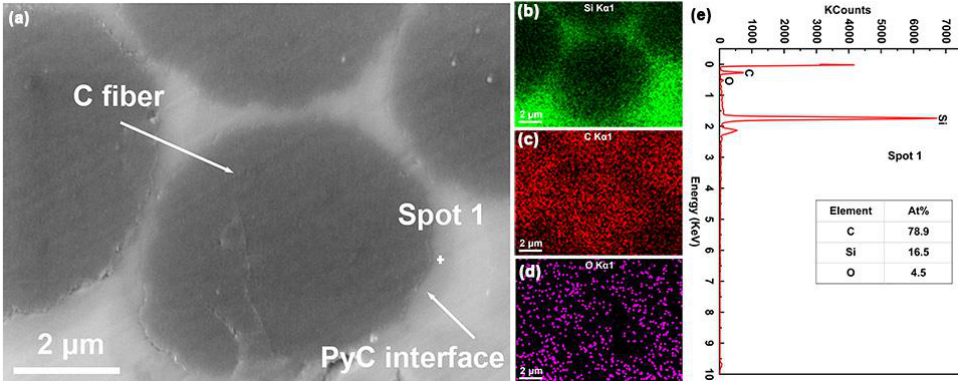
Figure 6. ( a ) Cross-sectional backscattered SEM micrographs of the C f /SiC-Al 2 O 3 composite and ( b – e ) corresponding EDS analysis. Table 3. General and mechanical properties of the C f /SiC-Al 2 O 3 composite.